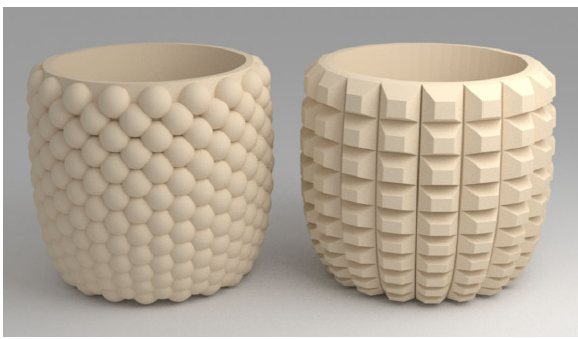
Figure 3. The 3D printed exteriors for the drinks held by participants in van Rompay et al. (2016) [32]. Finalized surface pattern variants (left panel: rounded surface pattern; right panel: angular surface pattern). Reproduced with permission from [32], © 2016 Elsevier Ltd.